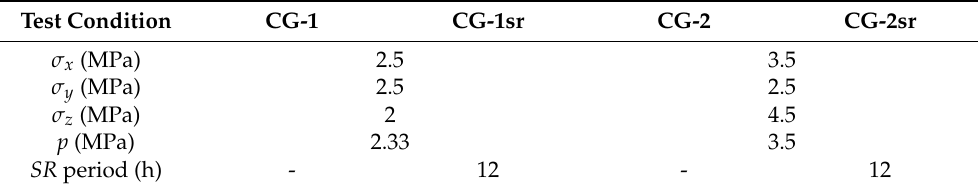
Table 3. Summary of seepage tests under various stress states involving time effect.